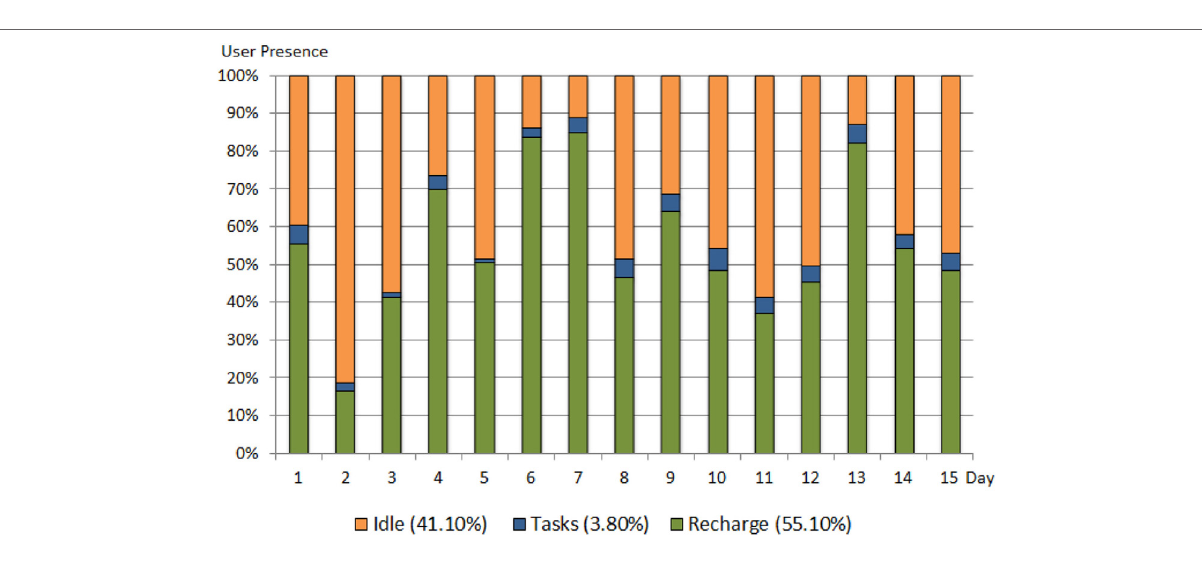
FigUre 4 | Time summary and activity breakup for 15